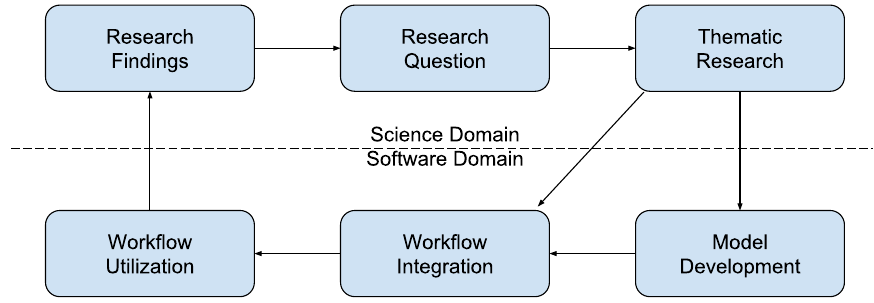
Figure 1. Development cycle of model workflows in the context of computational